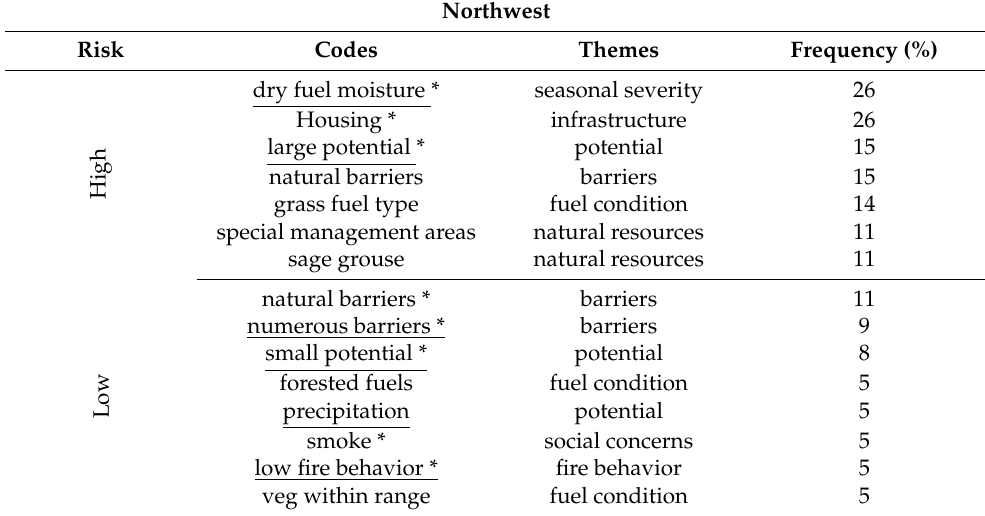
Table 3. Codes and associated themes that are more influential to distinguish high and low risk fires in the Northwest. Codes were included if they had a p -value < 0.05 and occurred with frequencies greater than or equal to 10% for high risk fires and 5% for low risk fires, ordered from more to less frequent. An asterisk denotes p < 0.005. Underlined codes were common to both Geographic Areas